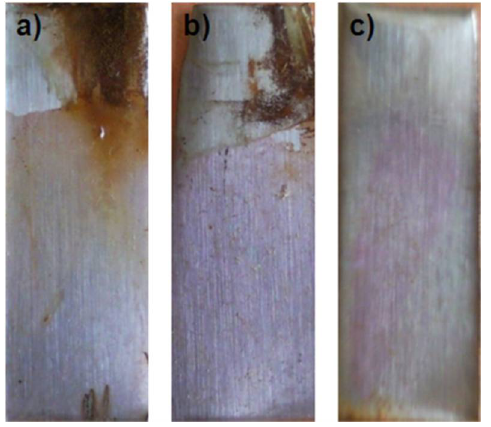
Figure 2. Durability tested samples after 600 h of immersion in 3.5 wt % of NaCl solutions. Coatings